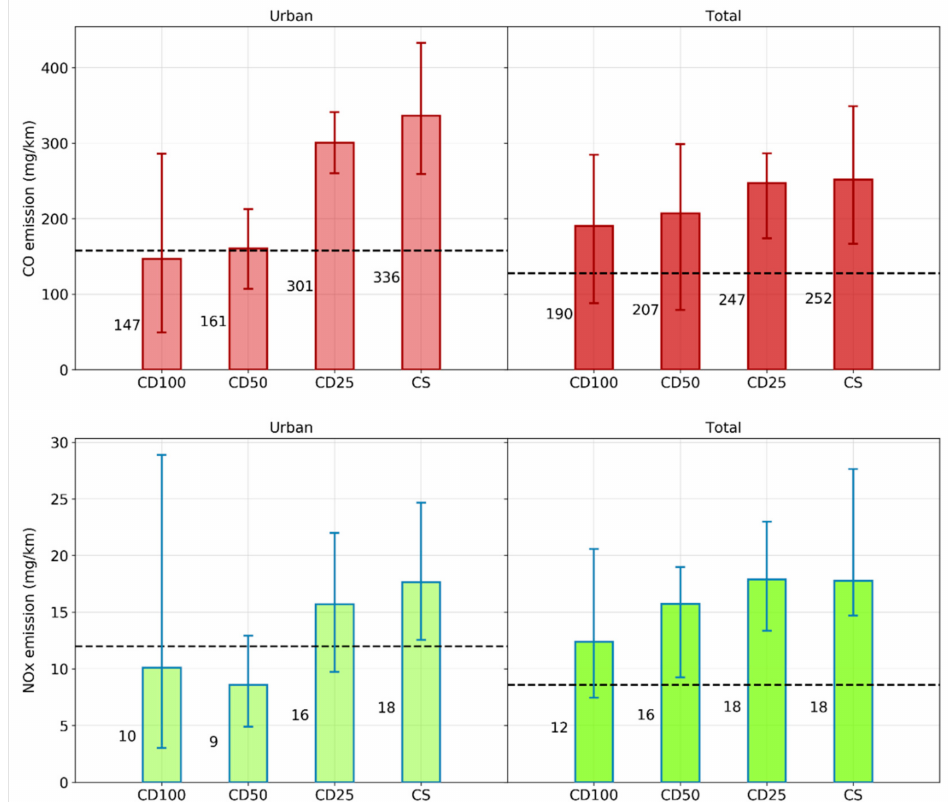
Figure 2. Regulated emissions on RDE compliant tests, averages of the three vehicles. CD100/50/25 indicates charge-depleting operation with initial battery state of charge (SOC) equal to 100/50/25%. CS indicated charge-sustaining operation, i.e., starting with the minimum SOC. Left panels report emissions for the urban phase, right panel for the complete test. Black dashed lines represent average emissions from the fleet of gasoline vehicles tested at the JRC in the 2018–2019 period in the framework of market surveillance [18]. All tests were performed in the default user-selectable mode of operation with the notable exception of a single CD50 test for vehicle #1 (fully electric mode). Error bars on the graph represent maximum and minimum values. See the Methods section and the Supplementary Materials for additional